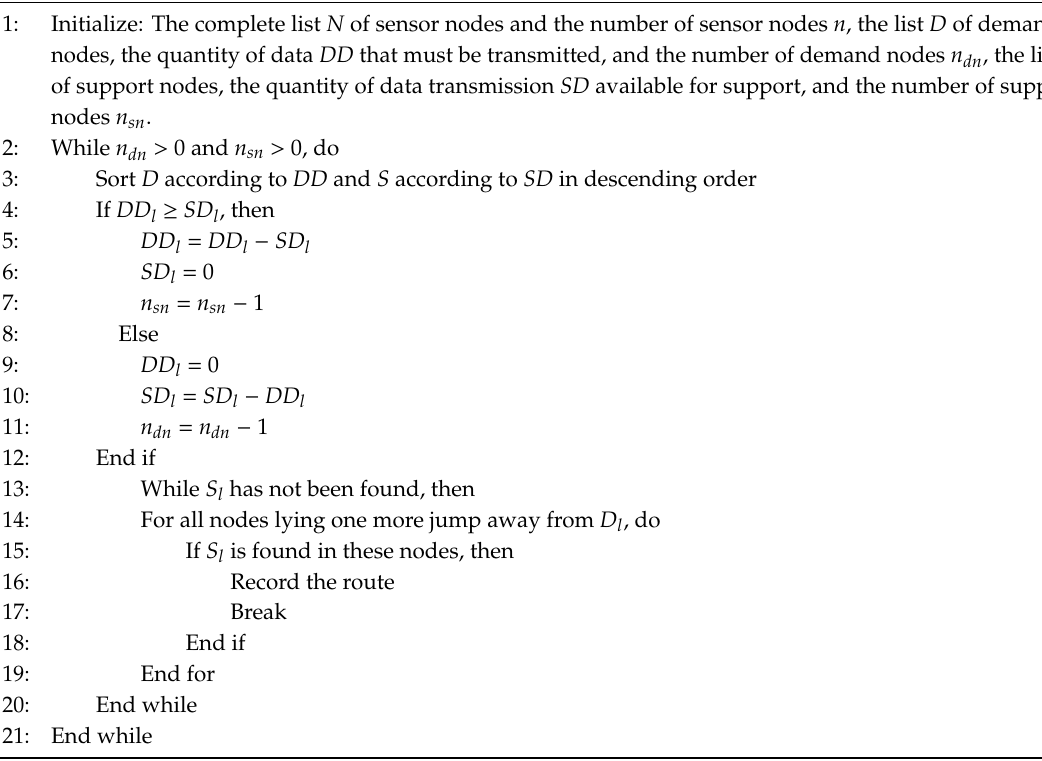
Algorithm 3 . Maximum Data Greedy Scheduling and the Di ff usion Route Finding